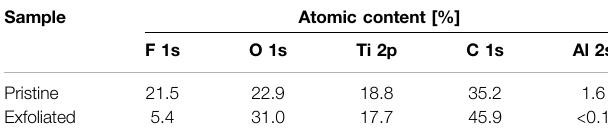
TABLE 2 | XPS atomic percentages of pristine and exfoliated Ti 3 C 2 T x MXene. Sample